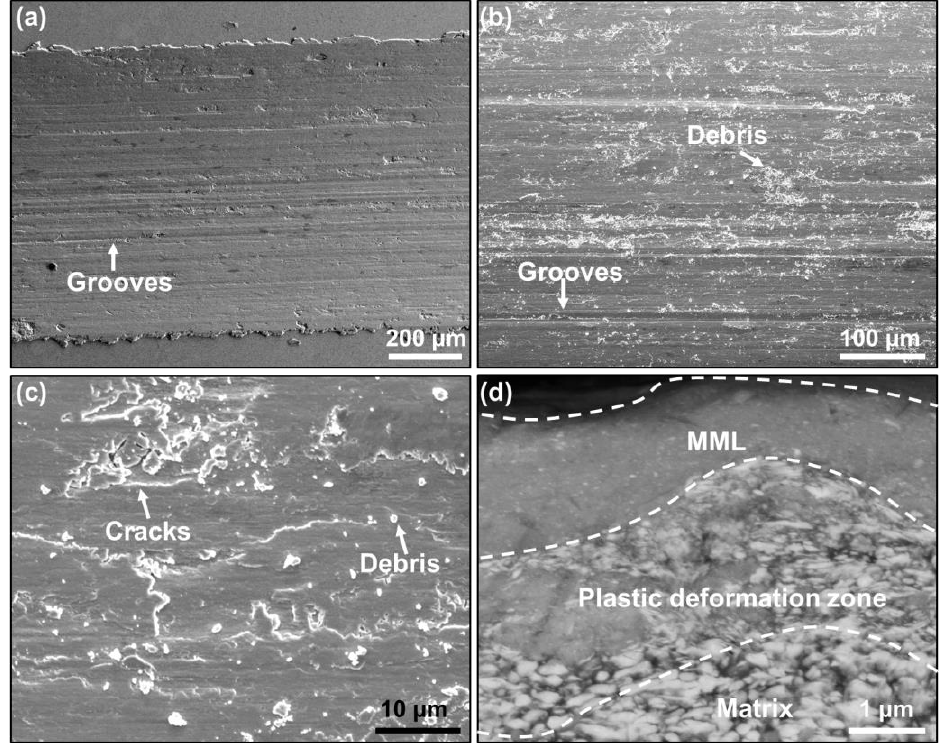
Figure 5. SEM images of worn surfaces ( a – c ) and cross-sectional microstructure under the wear scar ( d ) of the UFG W – Cu composite.